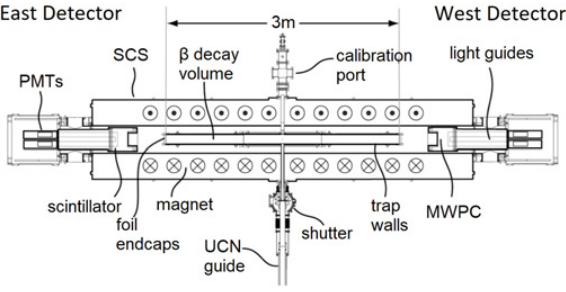
Figure 2. Schematic diagram of the UCNA experiment.